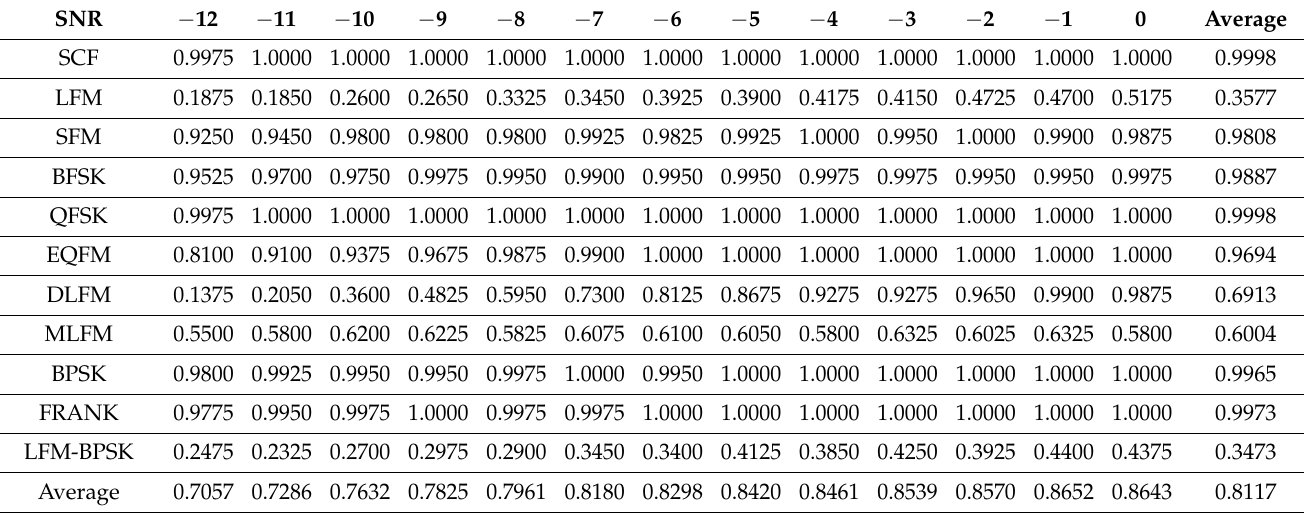
Table A16. Semi-supervised classification results with the datasets in Situation Dataset 4 without self-paced data augmentation ( T cycle = 100, NUM = 551).